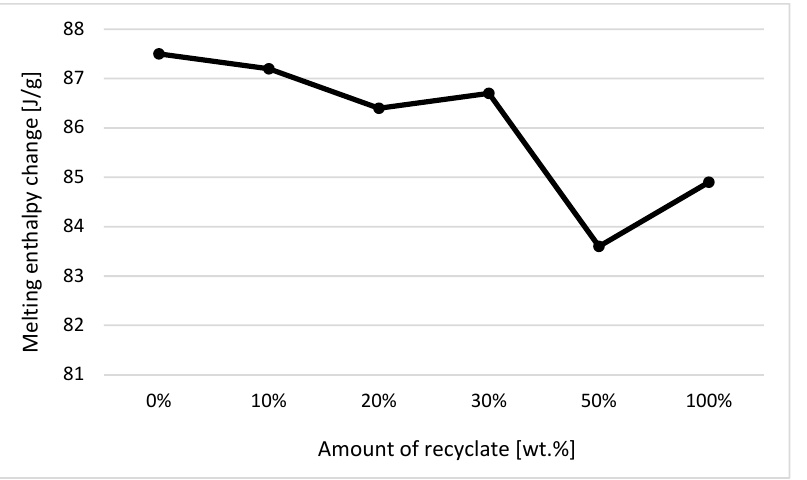
Figure 3. Dependence of the change in melting enthalpy on the proportion of weight of the recycled material before exposure of the samples to elevated temperature—component 2.